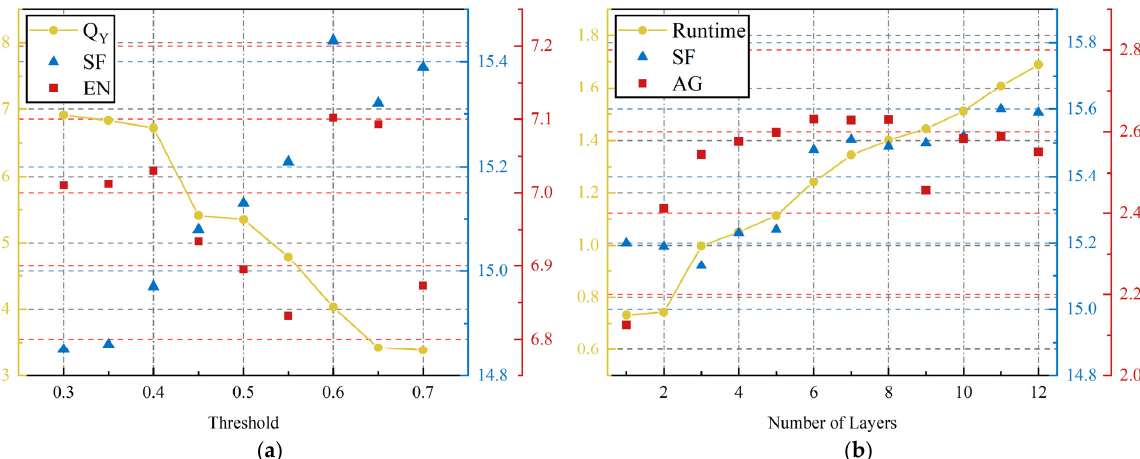
Figure 11. Ablation on the threshold and transformer (Q Y → 1/0: result tends to the visible/infrared sample; the default runtime unit is seconds). ( a ) Propensity performance. ( b ) Efficiency performance.